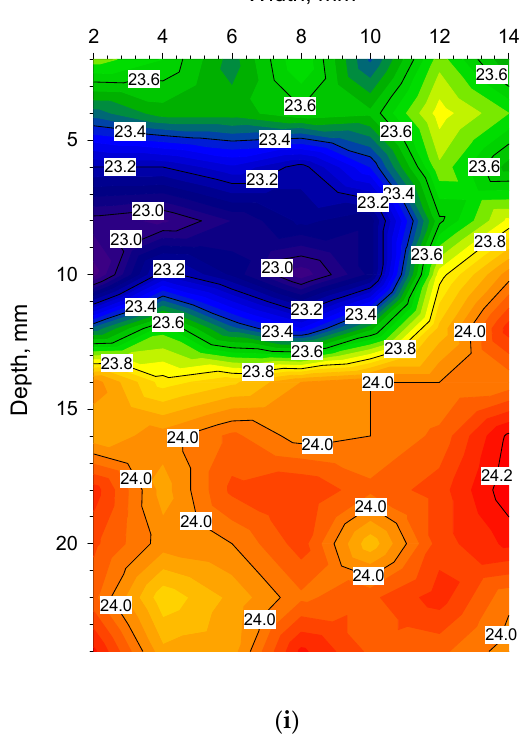
Figure 8. ( a ). Contour plot from 2.05 h displaying the freezing step where liquid is present at the surface. The temperature difference between top and bottom is maximum 1.5 °C. ( b ). Contour plot after 4 h, showing first freezing before annealing. Warmer zone still present at the top, up to 7 °C warmer than the bottom. ( c ). Contour plot after 7 h in the middle of the annealing step, where the top is 4 °C warmer than the rest of the material. The temperature is now 10 °C higher than after 4 h at the bottom of the cuvette. ( d ). Contour plot after 12.2 h during freezing where the material reached its lowest temperature of − 38 °C. There is a 7 °C di ff erence between central parts of the cuve tt e compared with the top. ( e ). Contour plot after 19.2 h in the sublimation step. Drying is taking place from the top downwards with a maximum difference of 5.5 °C between the top and bottom. Colour coding of temperature range − 18.46 °C to 2.56 °C is the same for ( e – g ), e.g., when comparing the top of ( e ) with the bottom of ( f ), the light blue is about − 12 °C in both figures. ( f ). Contour plot after 22.8 h in the sublimation step. The temperature has risen further and the difference is now 6 °C between the top and the bo tt om. Colour coding for temperature range − 18.46 °C to 2.56 °C is the same for ( e – g ). ( g ). Contour plot after 27.8 h in the sublimation step. The temperature has risen above 0 °C at the top indicating that the ice has been removed. Further down in the material, ice is still present. The temperature difference is now 6.5 °C between the top and the bottom. Colour coding for tempera ‐ ture range − 18.46 °C to 2.56 °C is the same for ( e – g ). ( h ). Contour plot after 38 h in secondary drying. Temperature difference is maximum 0.6 °C in the material. The material is 4 °C lower than the shelf temperature (set point 20 °C). ( i ). Contour plot after 41.7 h in secondary drying. The effect of the warm shelf can be seen (set point 30 °C). Colder area at the top could be indicative of evaporative cooling. In all other Figure 8a–h, the top is warmer than the bottom but at the end of the process, the situation is reversed. Temperature difference is 1 °C which is more than in ( h ).